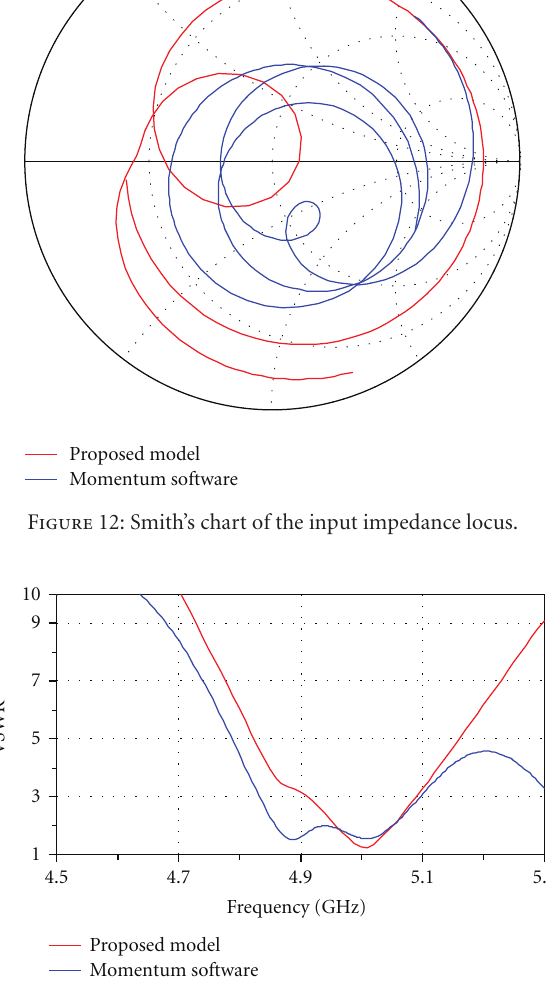
Figure 13: Bow-tie antenna array